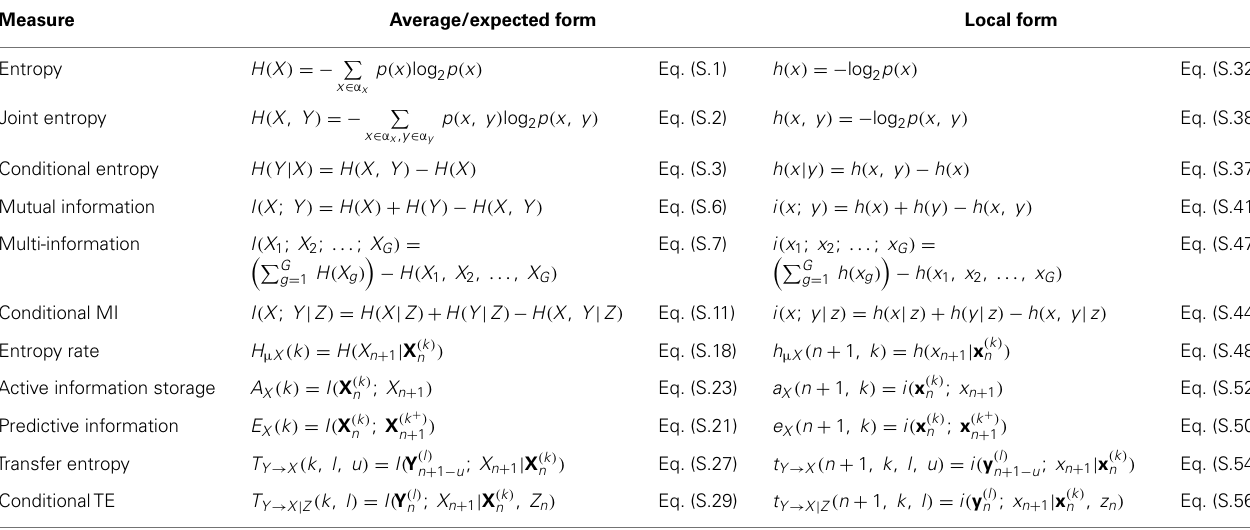
Table 1 | Basic information-theoretic quantities (first six measures) and measures of information dynamics (last five measures) implemented in JIDT